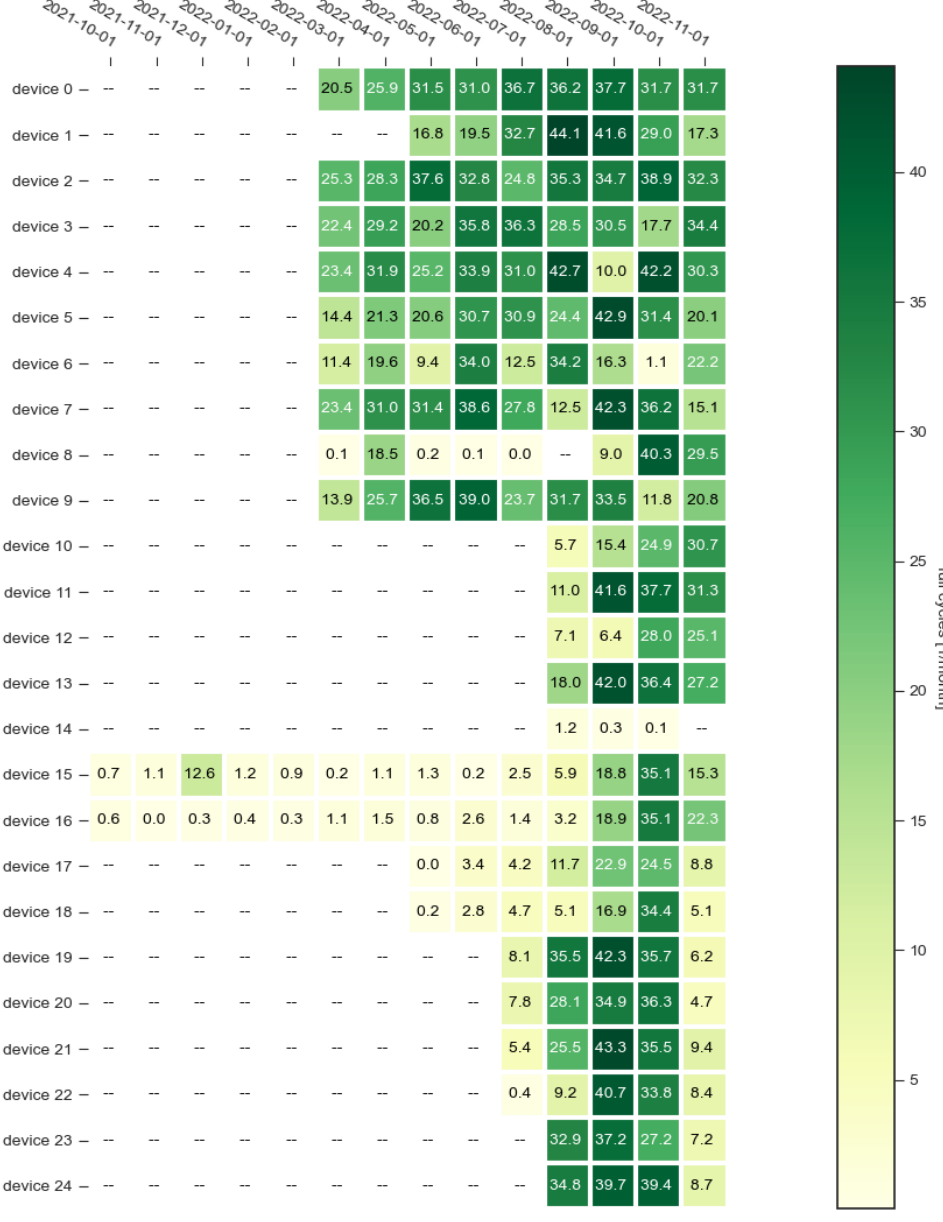
Figure 2. Logged full cycles of the selected subfleet 3 (one bus per row).